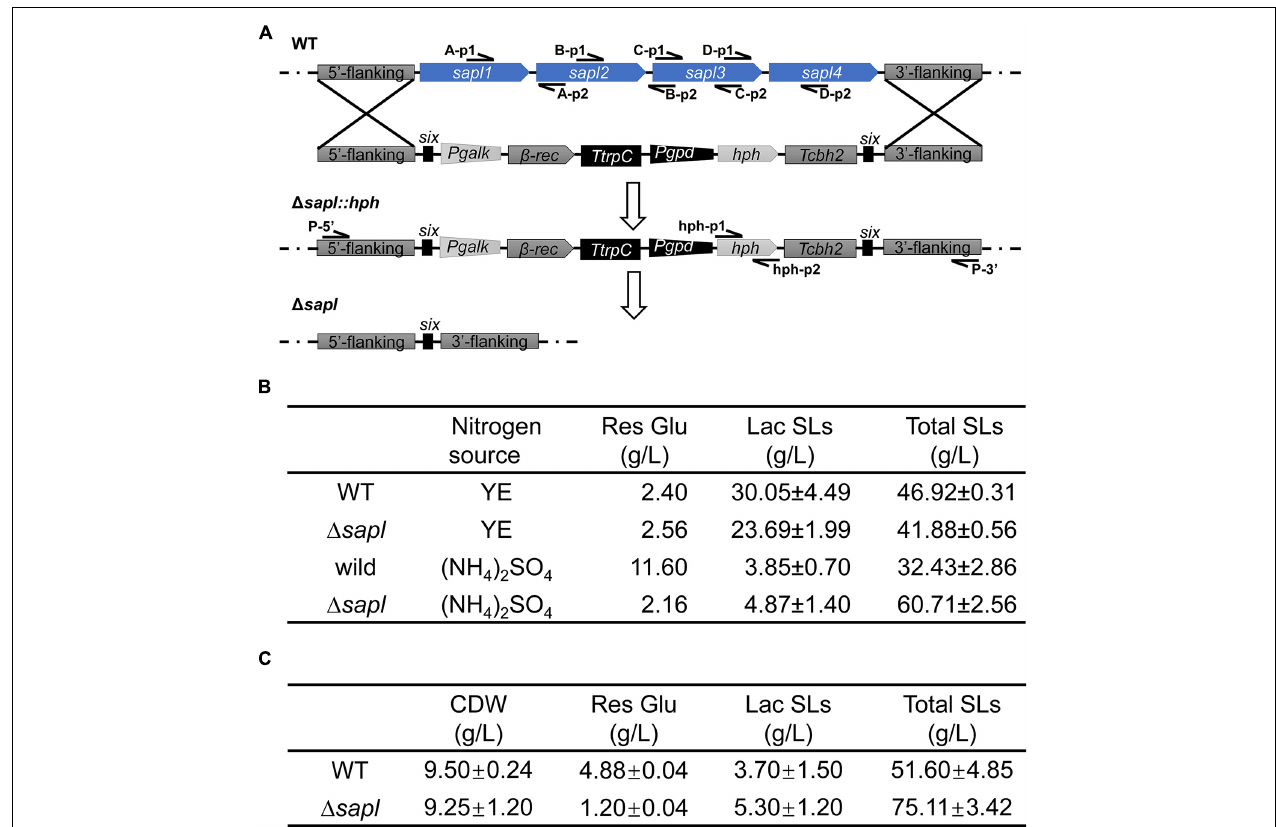
FIGURE 4 | The effect of deletion of sapl genes on the detection of SLs. (A) Construction of sapl genes knockout mutant (cid:49) sapl . Schematic illustration of the construction of (cid:49) sapl mutant by homologous recombination, and the deletion of self-excising hph marker performed by expression of β -rec recombinase under the induction of galactose. (B) Fermentation profiles of the wild-type strain and (cid:49) sapl strain for 5 days (WT, wild-type strain; YE, yeast extract; Res Glu, residual glucose; Lac SLs, lactone SLs; Total SLs, total SLs). (C) Fermentation profiles of the wild-type strain and (cid:49) sapl strain for 7 days with ammonium sulfate as source (WT, wild-type strain; CDW, dry cell weight; Res Glu, residual glucose; Lac SLs, lactone SLs; Total SLs, total SLs).